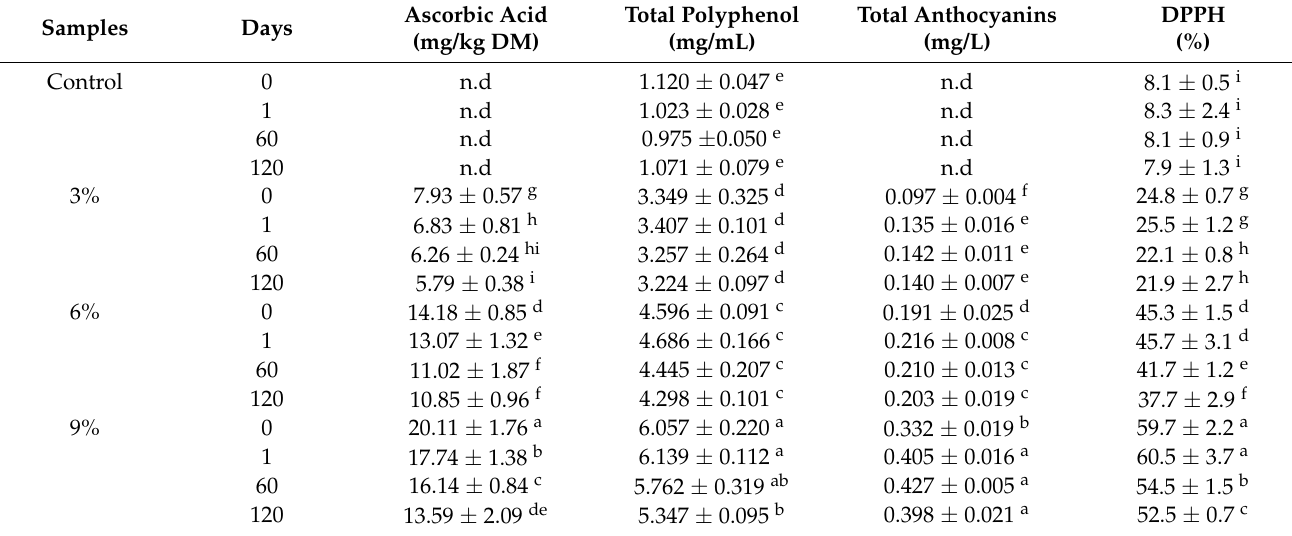
Table 4. Bioactive compound content in the probiotic ice cream mixes, after freezing and during storage.